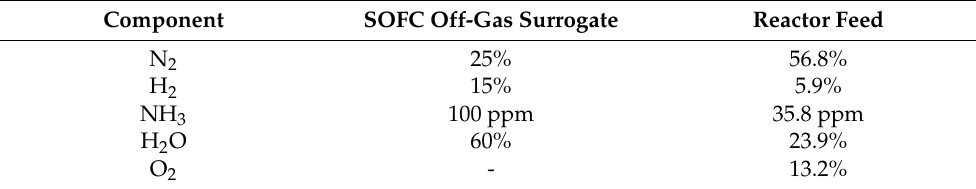
Table 2. Composition of the model off-gas surrogate and feed gas used for the catalytic tests.